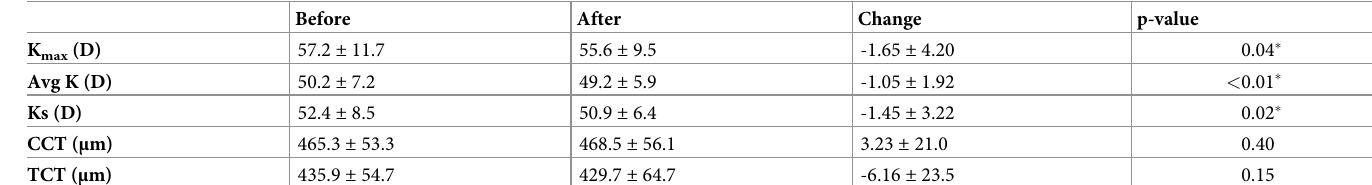
Table 1. Changes in keratoconus progression indices before and after the use of a rigid gas-permeable contact lens. Before After Change p-value